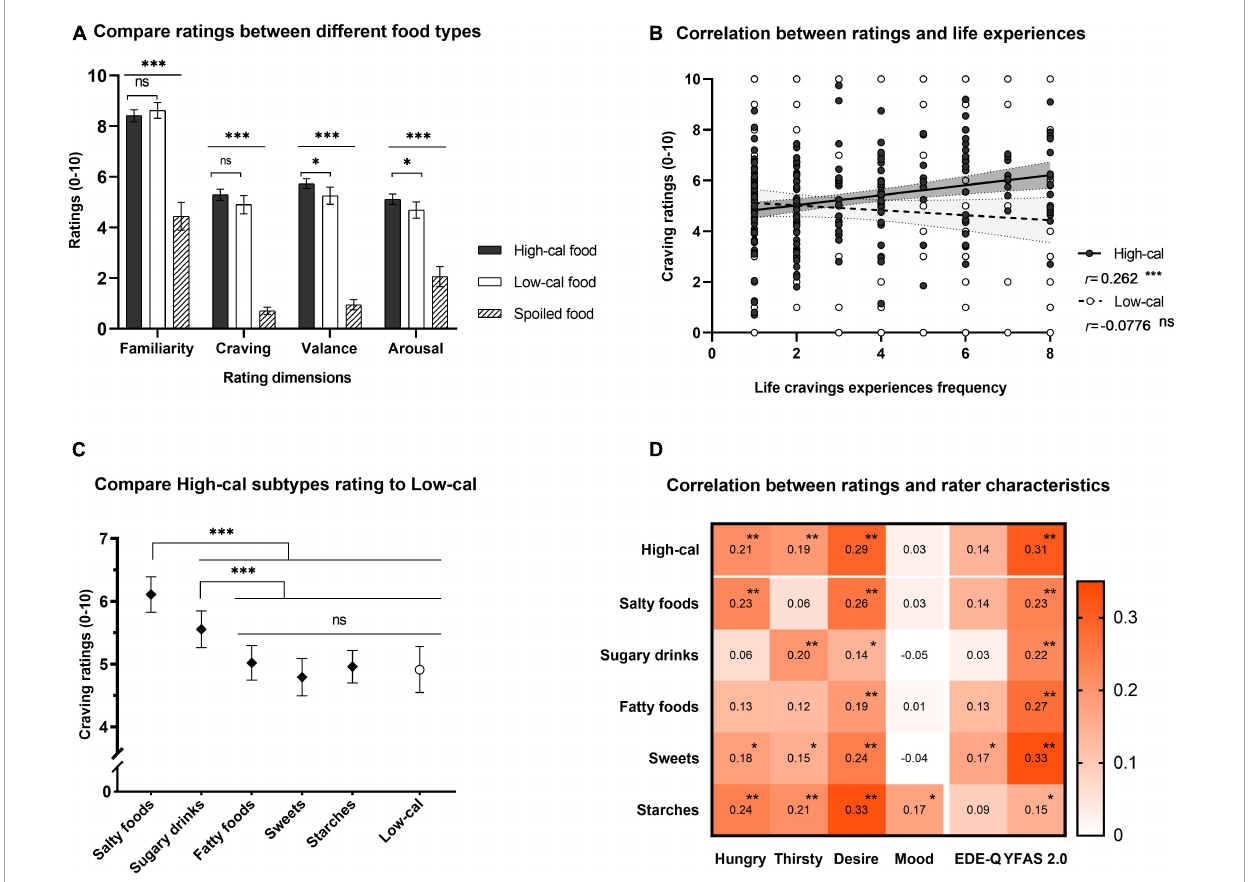
FIGURE2 Statistical analysis of PLCF ratings. (A) Histogram of one-way repeated-measures ANOVA results for each rating dimension. All ratings of palatable food (i.e., high- and low-calorie) images were significantly higher than those of spoiled food. Ratings of high- and low-calorie images significantly differed on the valence and arousal dimensions but not on the craving dimension. Solid bars indicate high-calorie foods, hollow bars indicate low-calorie foods, and diagonal lines indicate spoiled foods [same in panels (A–C) ]. (B) Scatter chart of the Pearson correlation between craving ratings and craving experience frequency in daily life. The frequency of craving experiences in life was positively correlated with the cravings induced by high-calorie images and was uncorrelated with those induced by low-calorie images. A linear fit was conducted separately, and the shading within the dotted lines indicates the 95% CI. (C) Dot plot of the results from one-way repeated-measures ANOVA with six levels (i.e., five subtypes of high-calorie food and low-calorie food). The cravings induced by salty food and sugary drink images were greater than those induced by low-calorie images. The diamond symbols indicate subtypes; the circles indicate food types. (D) Heatmap of the correlation coefficient between the craving ratings of high-calorie food images and rater characteristics. The cravings induced by high-calorie food images were positively correlated with the baseline desire to eat and the severity of food addiction measured by YFAS 2.0. However, there was only one correlation with the severity of eating disorder symptoms measured by EDE-Q. EDE-Q, eating disorder examination questionnaire; YFAS, Yale Food Addiction Scale 2.0. For all subplots, *** indicates p < 0.001, ** indicates p < 0.01, * indicates p < 0.05, and “ns” indicates no significance. The error bar indicates the 95%